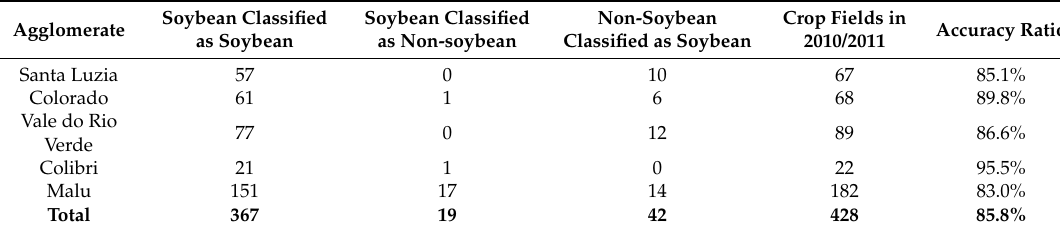
Table 1. Classification errors detected by the punctual crop field area analysis. Agglomerate